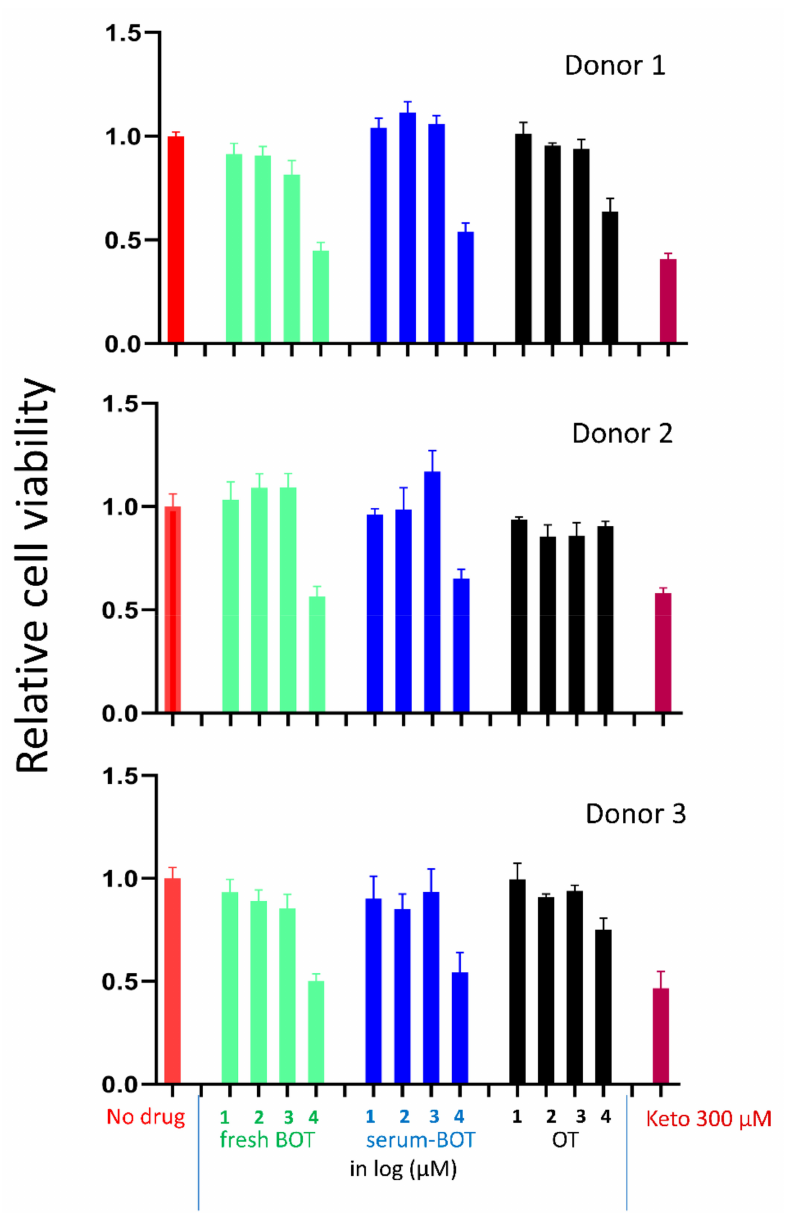
Figure 2. Relative viability of cells in 3 cultures of primary human gingival fibroblasts derived from 3 unrelated donor teeth. Fresh B-OT: fresh benfooxythamine; serum B-OT: benfooxythamine preincubated in serum-containing medium overnight at room temperature. OT: oxythiamine. Keto: